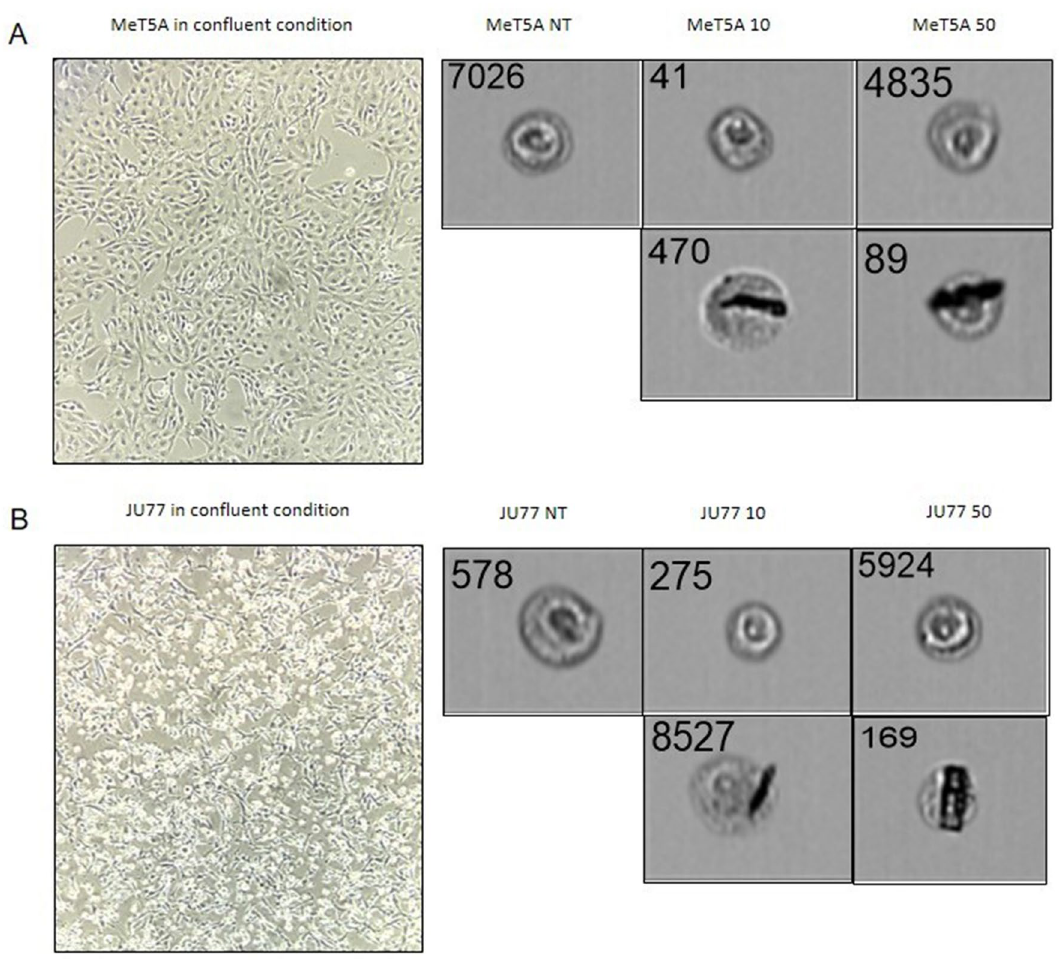
Figure 7. Morphology of cells in confluent condition immortalized through Nikon microscope Eclipse Ts2 (magnification 10x), and morphology of single cells immortalized through FlowSight Imaging Flow Cytometer after no exposure, exposure to 10 ug/ml FE fibers, and exposure to 50 ug/ml FE fibers (magnification 20x) for: A) MeT-5A (human normal mesothelium); B) JU77 (human malignant